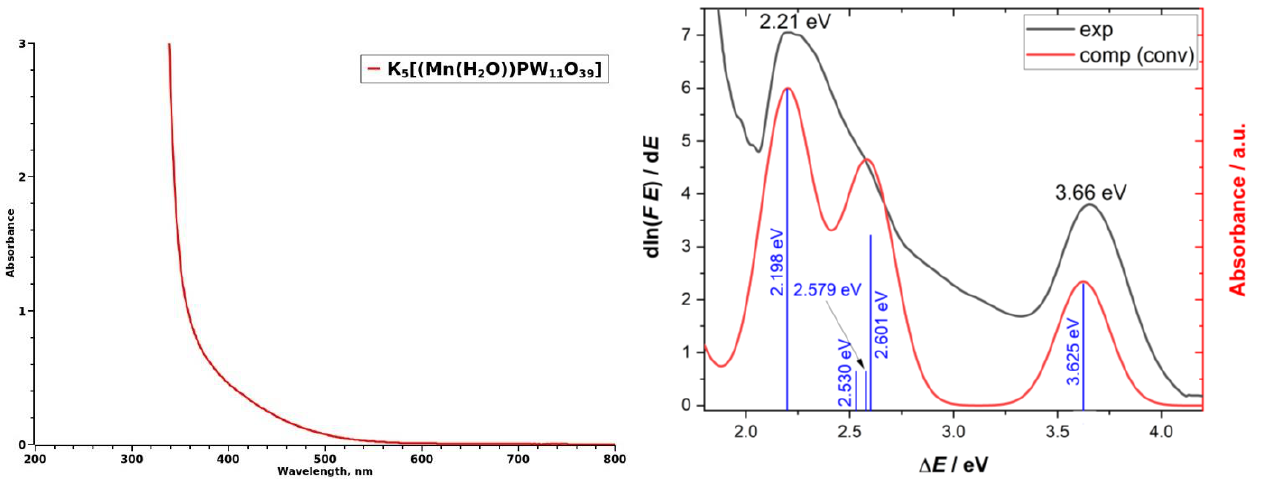
Figure 2. UV–Vis spectrum of 1 in water at natural pH ( left ); Experimental (black curve) and calculated (red curve) DR spectra of 1 ( right ).